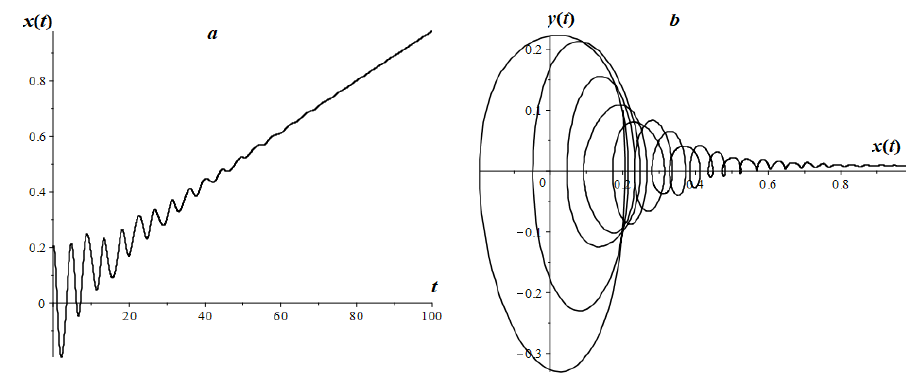
Figure 17. Aperiodic mode of the Mathieu fractional oscillator with no friction in the free oscillation mode: ( a ) oscillogram; ( b ) phase